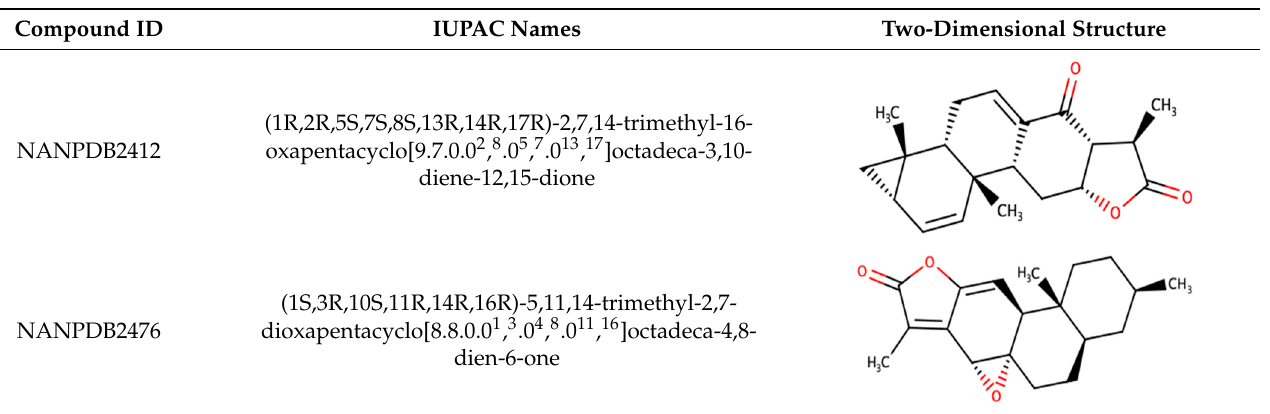
Table 8. List of two-dimensional structures of potential lead compounds obtained using Marvin Sketch (ChemAxon Ltd., MarvinSketch version 17.28.00, Budapest, Hungary) [134].